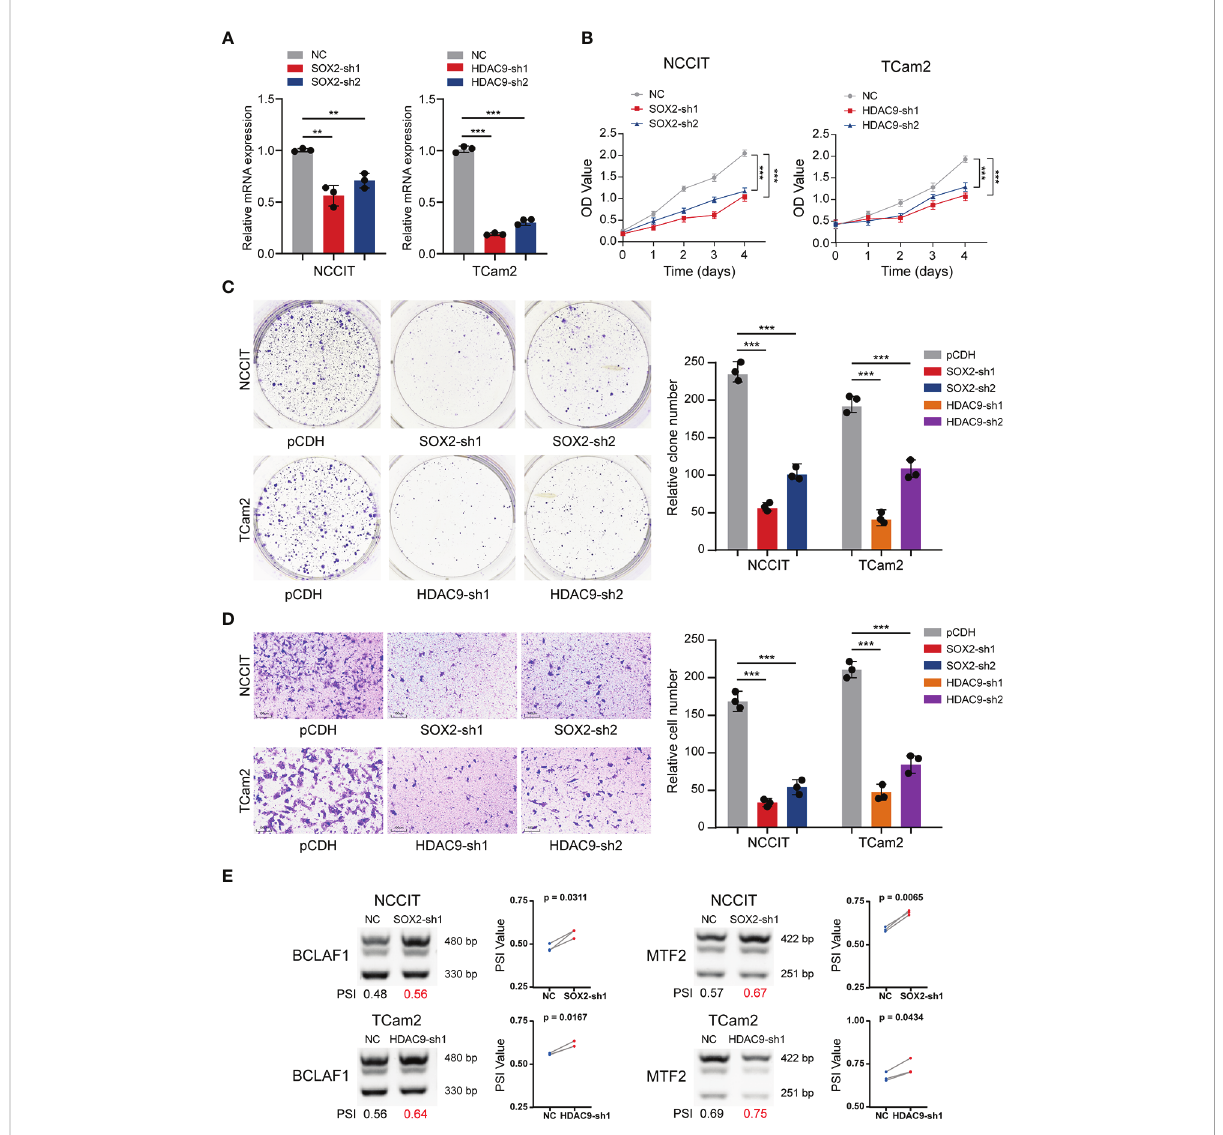
FIGURE 5 Validation experiments of SOX2 and HDAC9 in TGCT cell lines. (A) The ef fi ciency of TGCT cell lines stably silencing SOX2 and HDAC9 was validated by RT-PCR. (B, C) CCK-8 and Colony formation assays were performed in TGCT cell lines. (D) Transwell migration assay was applied in TGCT cell lines. (E, F) Semi-quantitative PCR was performed to detect the alternation of PSI value of DAS events in cell lines after silencing SOX2 and HDAC9. *** P < 0.001, ** P <